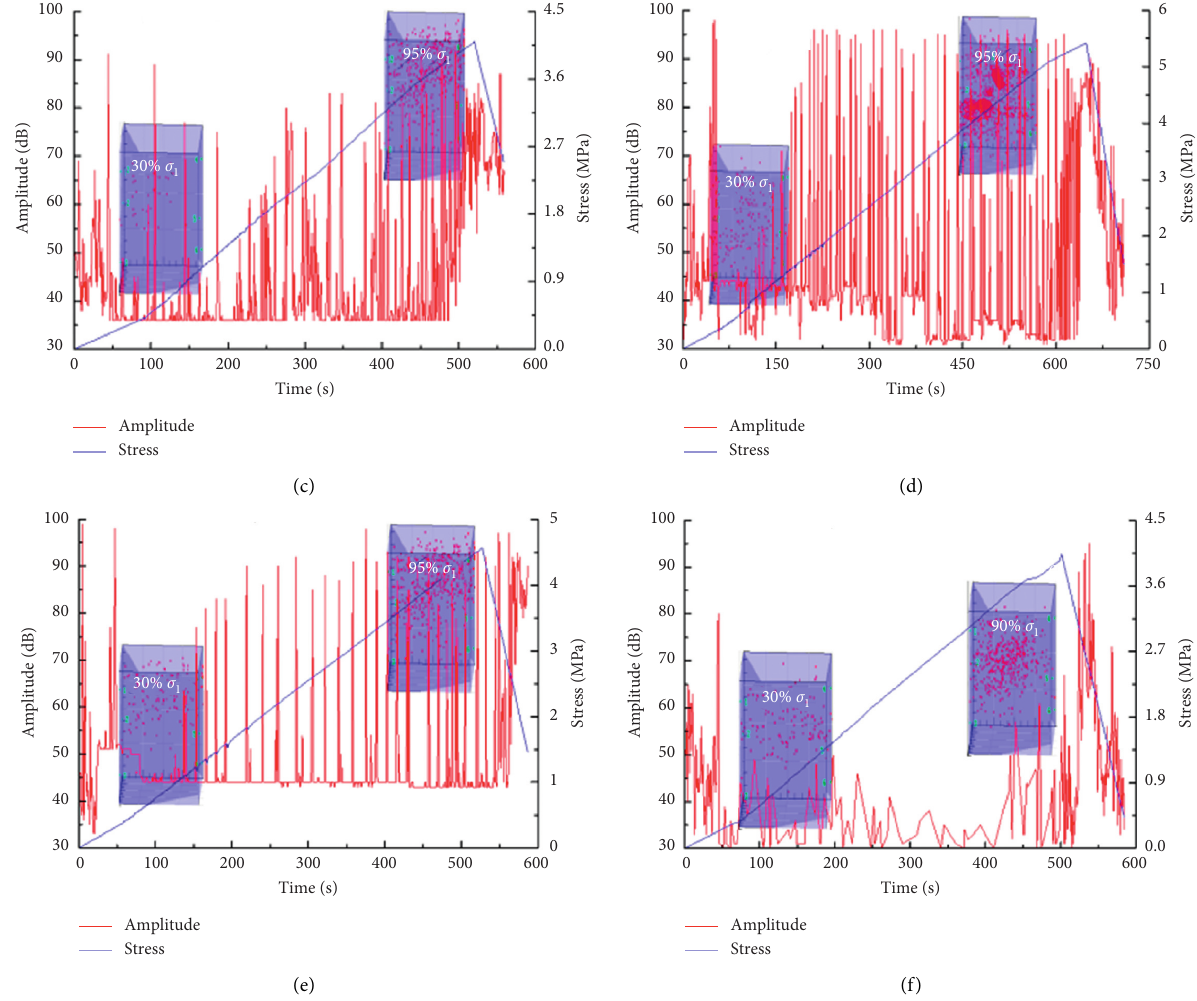
Figure 6: Stress-time curves and spatial distribution of AE events at different stress levels: (a) A -1, (b) A -2, (c) B -1, (d) B -2, (e) C -1, and (f) C